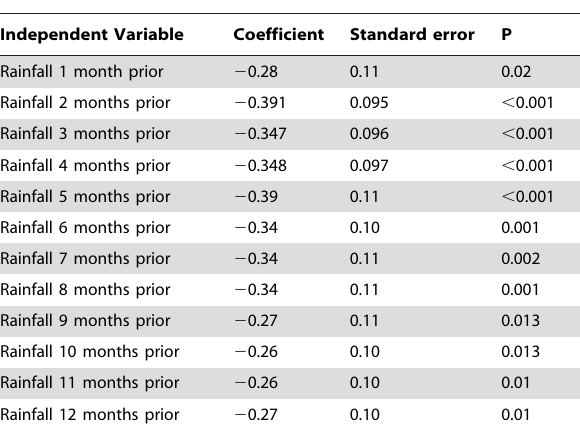
Table 2. Statistical effects of rainfall for one to 12 months prior to sample collection on faecal cortisol concentration (Coefficients from standardized models (effect sizes)).